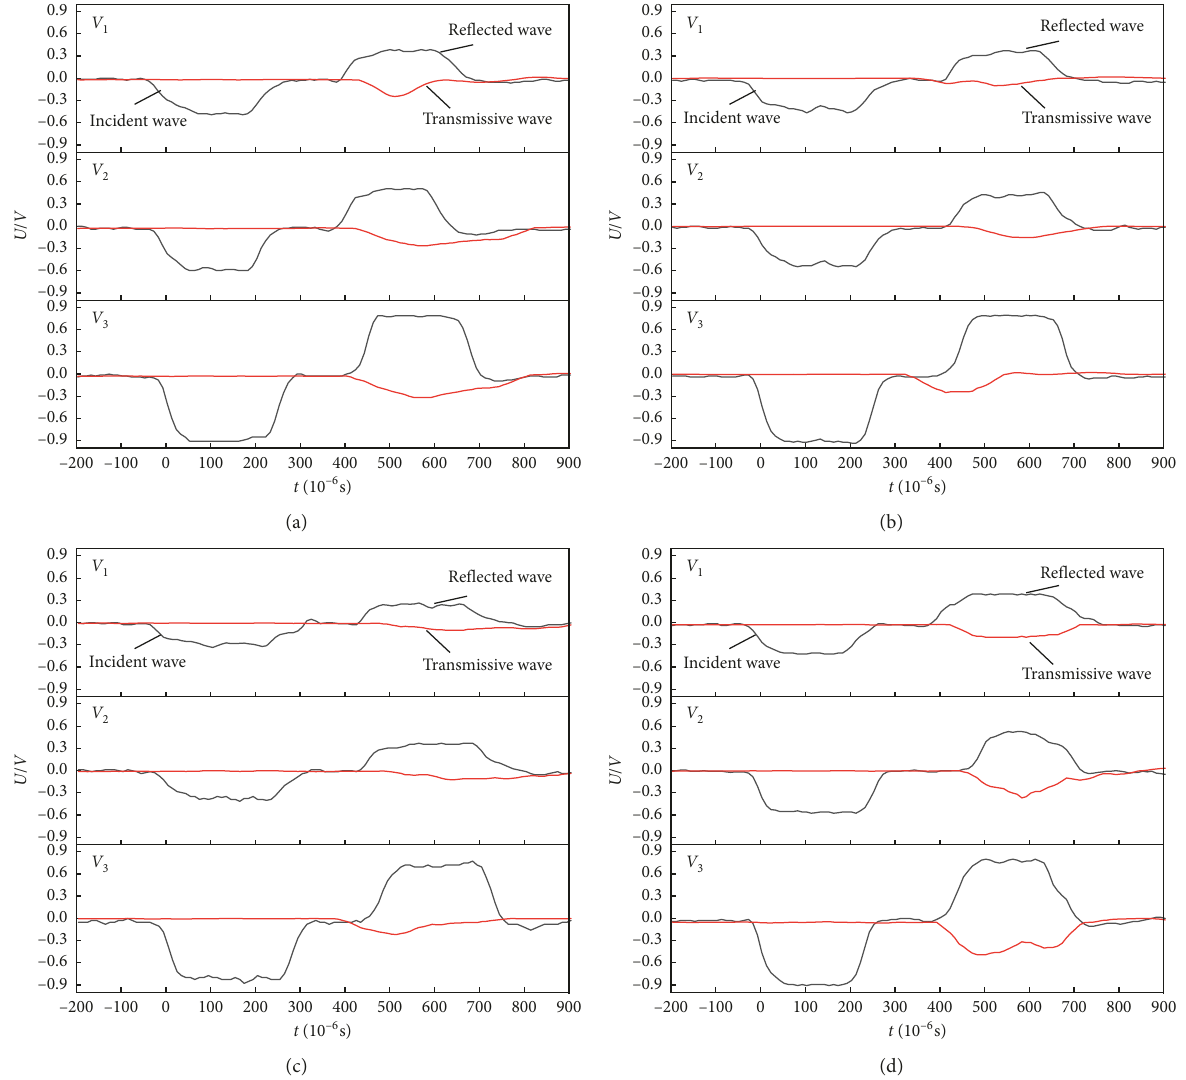
Figure 4: Morphology of 4mm filled joint specimens under impact at different impact velocities. The shape of 0 ° (a), 30 ° (b), 45 ° (c), and unjointed (d) rock mass specimens under different impact velocities.